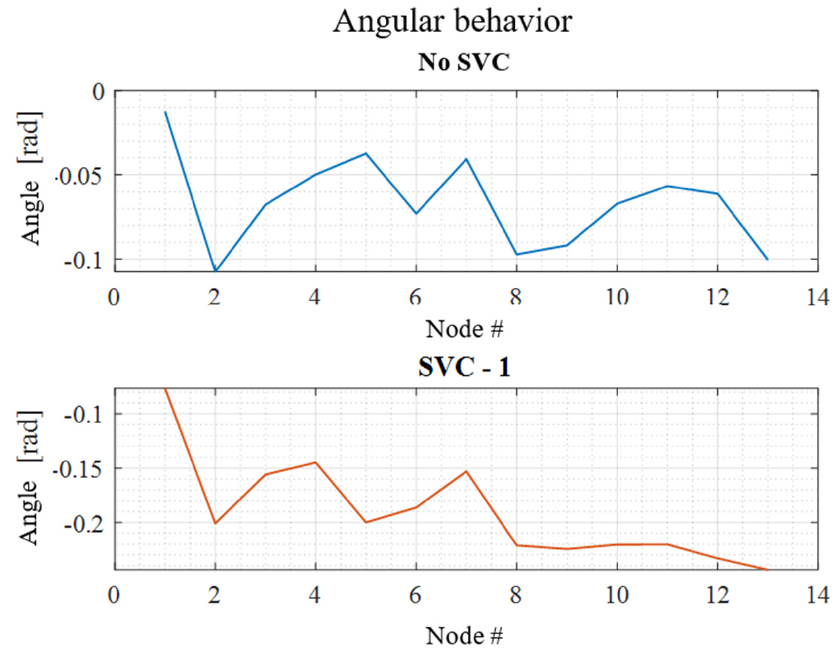
Figure 7. Angle profile in the IEEE 14-bus test system.